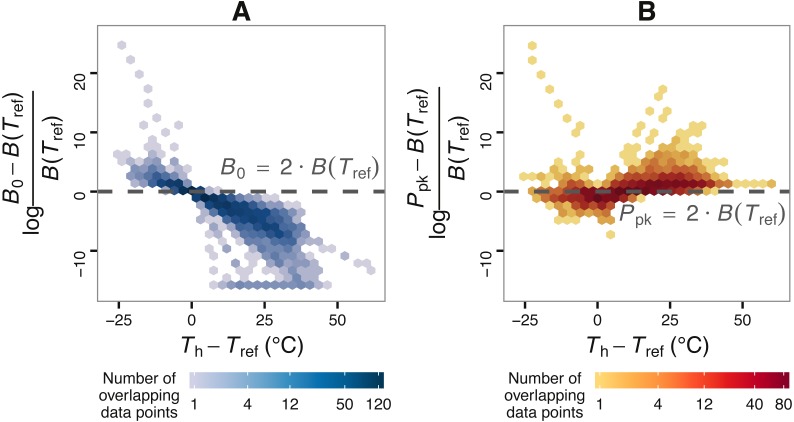
The effect of choice of reference temperature Tref on the deviation of B0 from B(Tref) (A) and its relationship with Ppk (B).The vertical axis of (A) stands for the log-fold increase of B0 from B(Tref), where a value of zero indicates that B0 is double the real B(Tref) value. Zero is used here as a reference point around and above which B0 becomes non-negligibly exaggerated. Data points were obtained by fitting the Sharpe-Schoolfield model to a dataset of phytoplankton growth rate measurements versus temperature (see main text) across a range of Tref values. The colour depth of each hexagon is proportional to the number of data points at that location in the graph. As expected from Eq. (2), the deviation of B0 from B(Tref) decreases nonlinearly with the difference between Th and Tref, to the point where the former asymptotically approaches zero (in linear scale). Towards the left end of the horizontal axis, the values of the estimates of B0 even exceed those of the rate value at or close to optimum, Ppk.